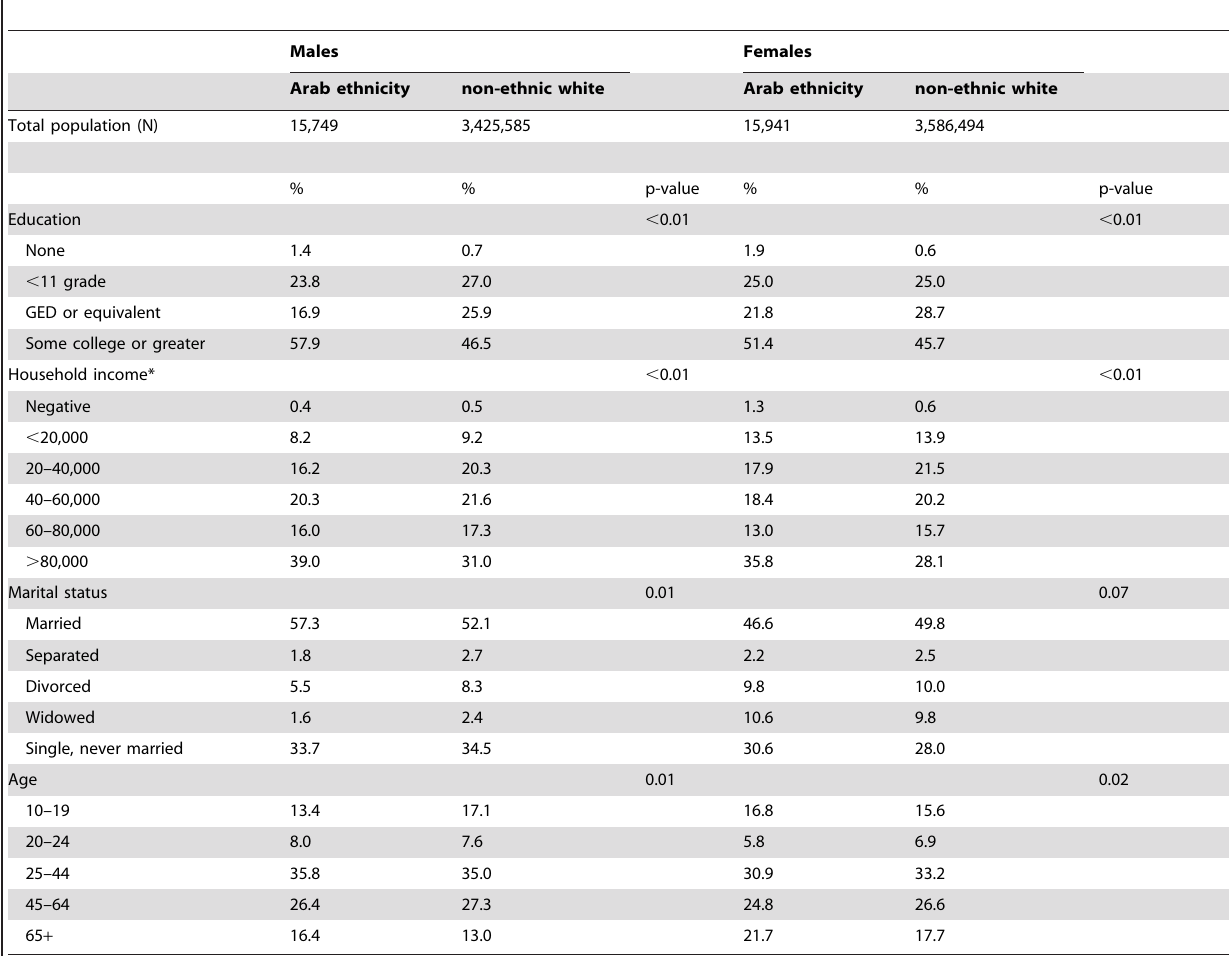
Table 1. Demographic characteristics of Arab-American and non-ethnic white males and females aged 10 and older in Michigan, 2000.